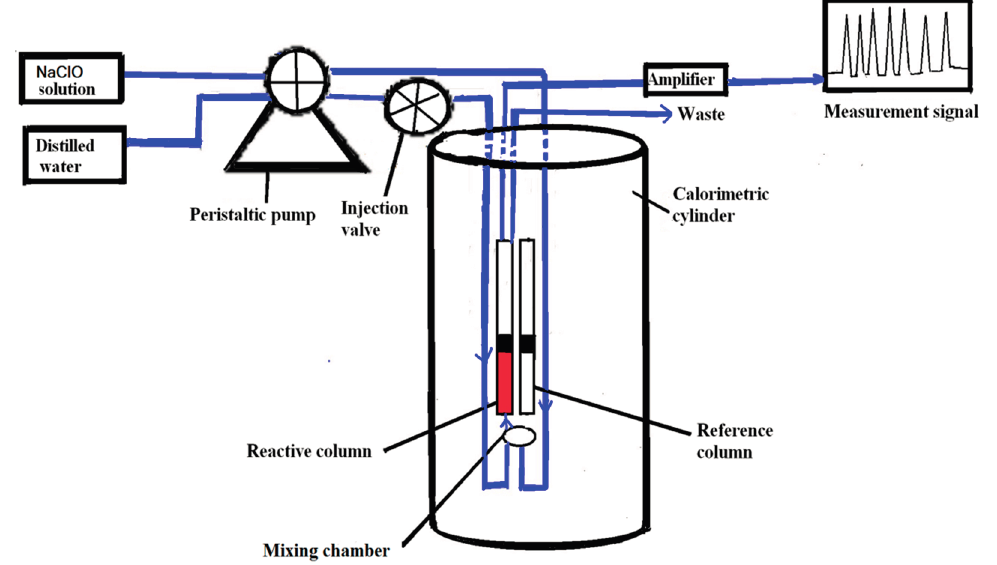
Figure 1. Schematic of the thermal sensor instrument for COD